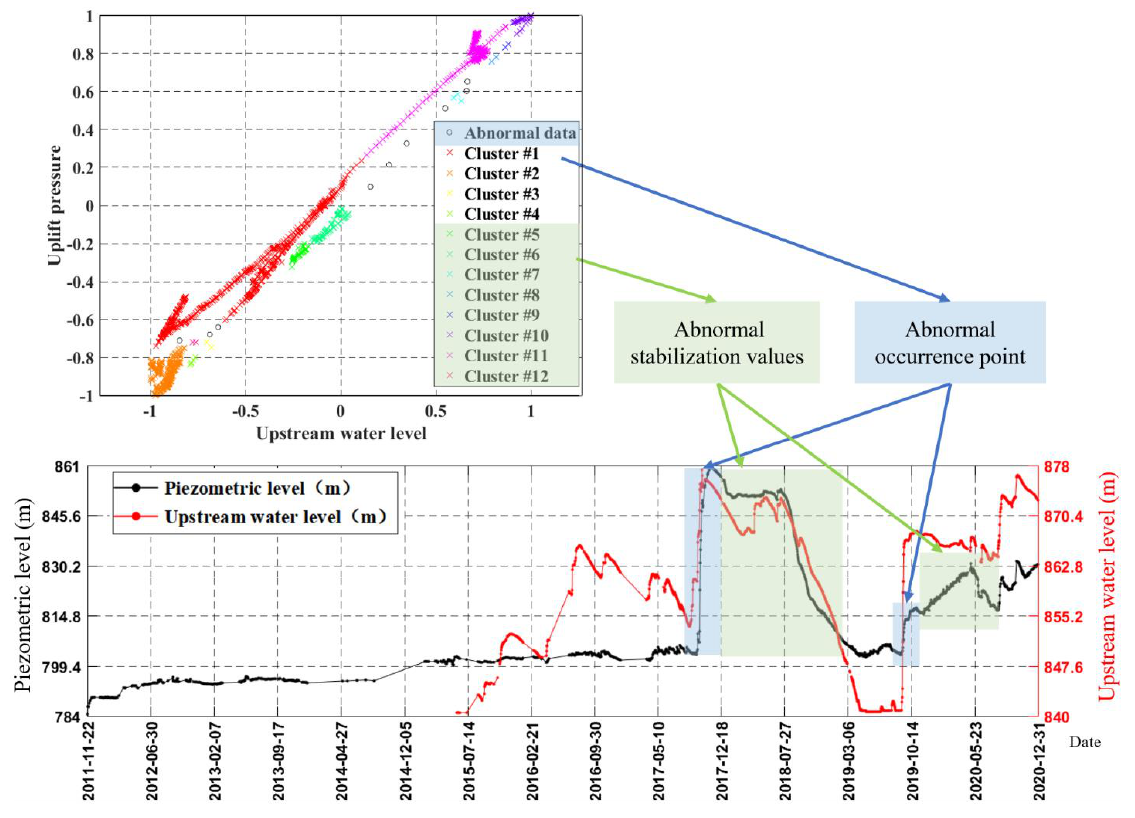
Figure 7. Anomaly identification result of uplift pressure at the P2-3 monitoring point.